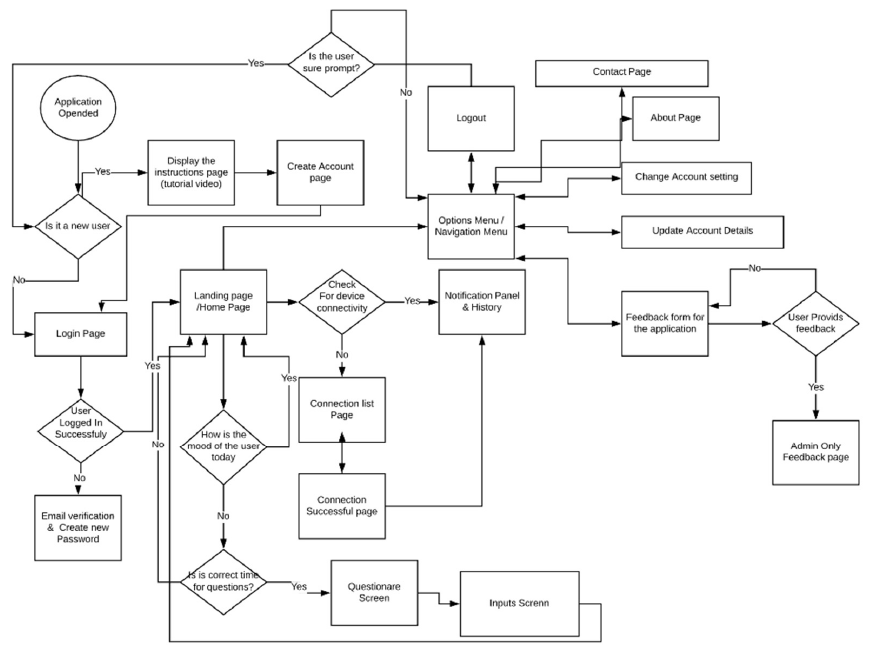
Figure 2. Logic flow of the iMOVE app.